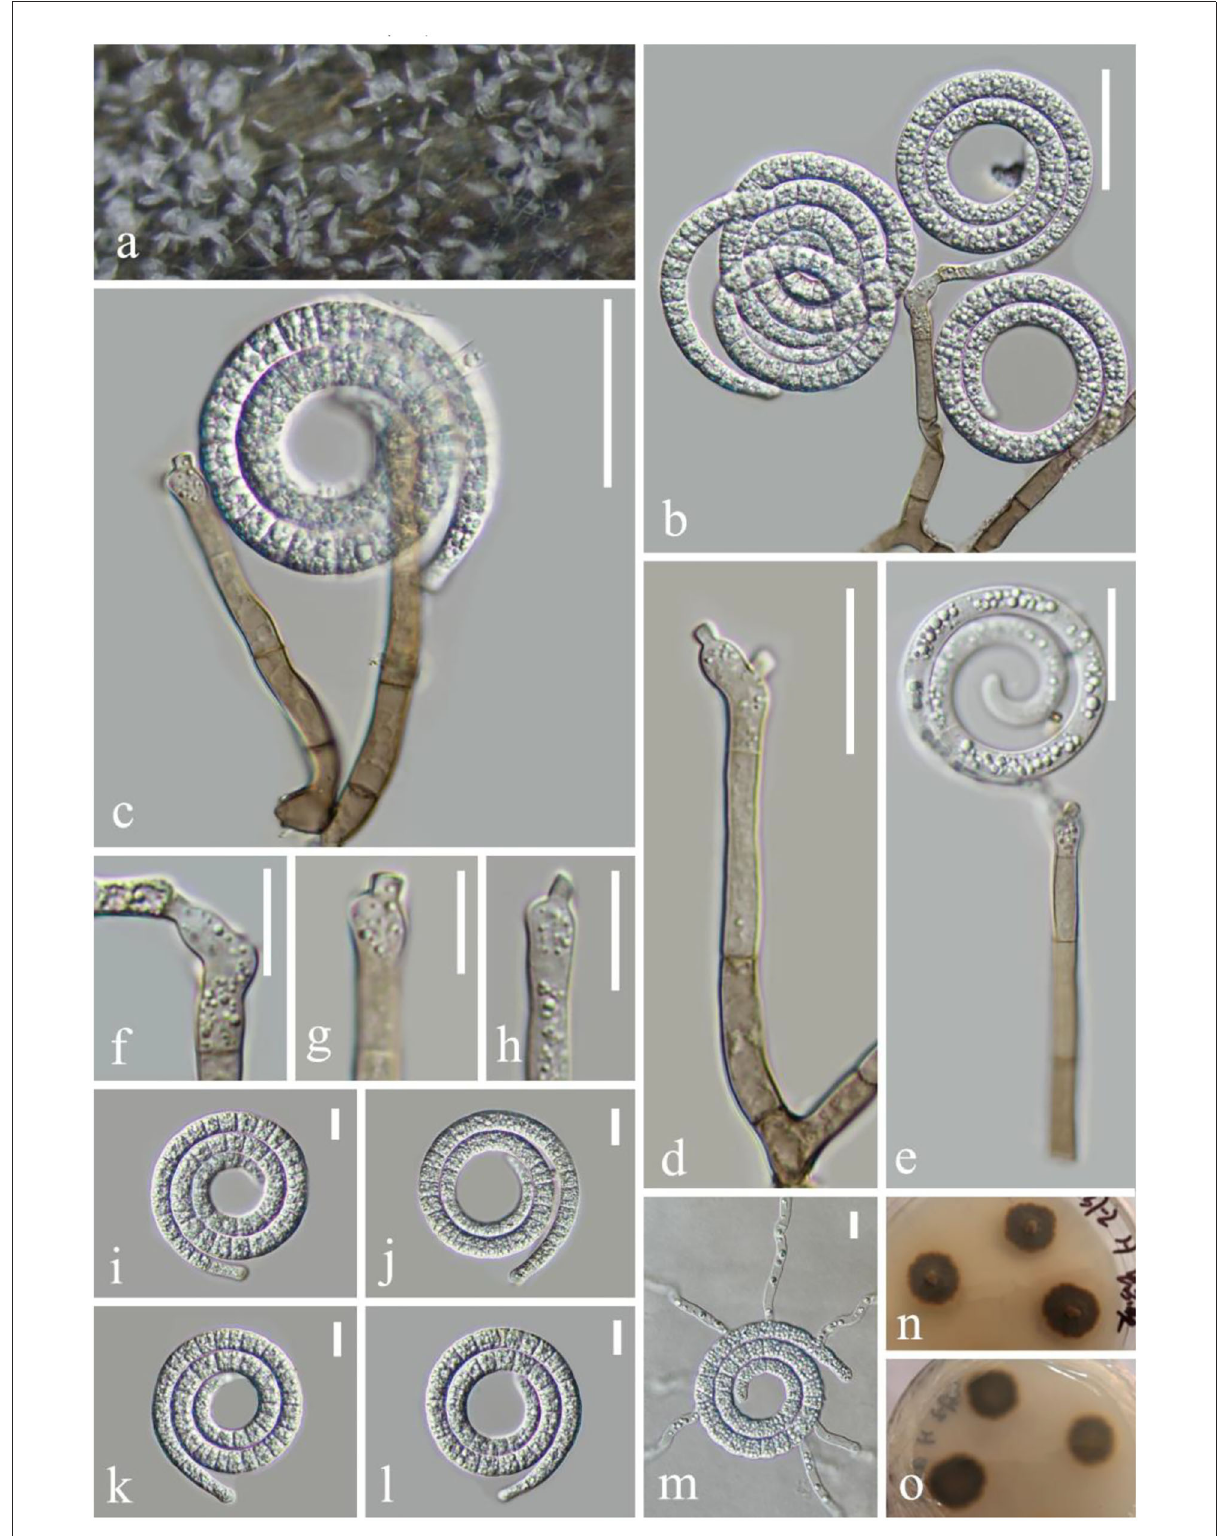
FIGURE4 Neohelicosporium suae (KUN-HKAS 124610, holotype). (a) Colony on decaying wood. (b,c,e) Conidiophores with attached conidia. (d) Conidiophores. (f–h) Conidiogenous cells. (i–l) Conidia. (m) Germinating conidium. (n,o) Colony on PDA observed from above and below. Scale bars: (b,c) 30 µ m, (d,e) 20 µ m, and (f–m) 10 µ